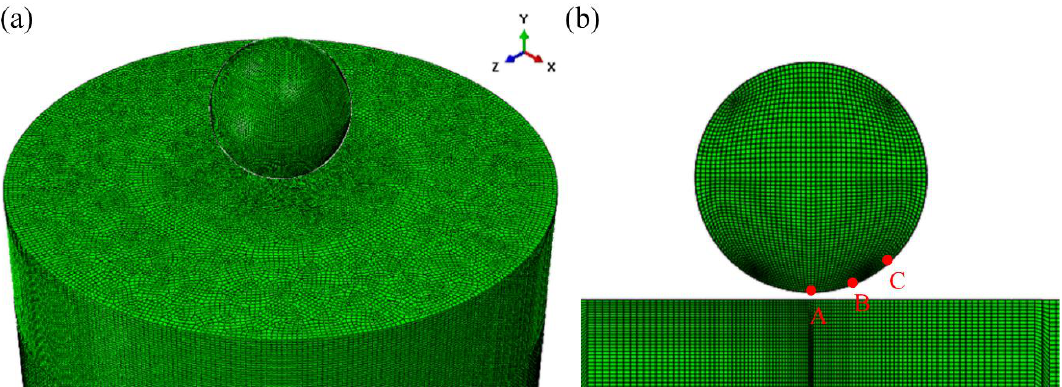
Figure 3. Figure 3. ( a ) Finite element mesh of a full 3D model for a single particle’s normal impact onto the substrate and ( b ) a zoom-in view of the particle–substrate interface with the respective locations of elements A, B and